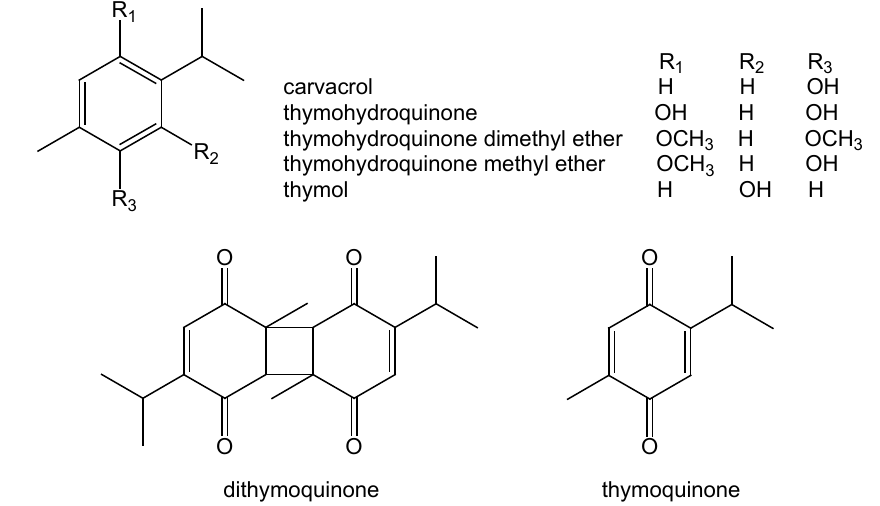
Figure 1. The chemical structures of quinones and related compounds detected in analysed plant